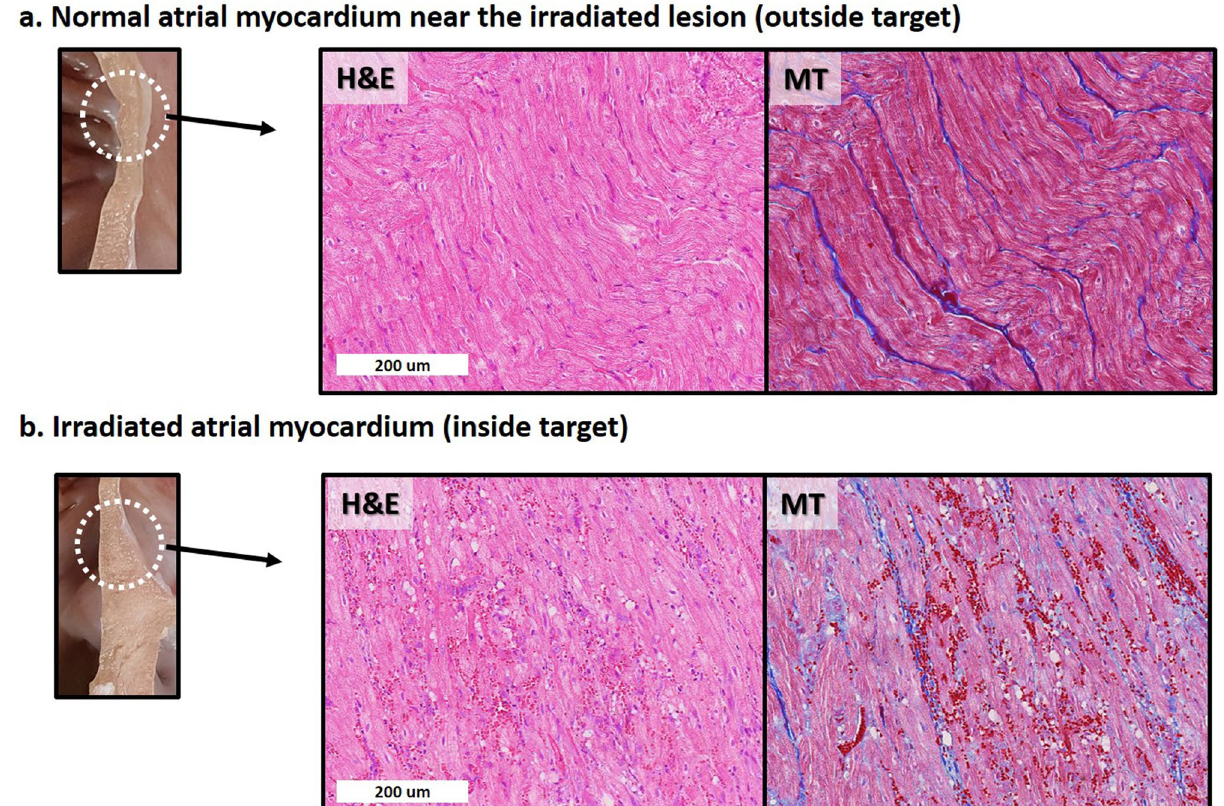
Figure 4. Histologic changes after irradiation at 6 weeks. There is no gross lesion at 6 weeks. However, from the light microscopic evaluation with H&E and MT staining, compared to normal atrial myocardium near the irradiated lesion ( a ), irradiated atrial myocardium ( b ) shows diffuse vacuolization with extensive hemorrhage and inflammatory cell infiltration with dilated capillaries. H&E hematoxylin and eosin, MT Masson’s